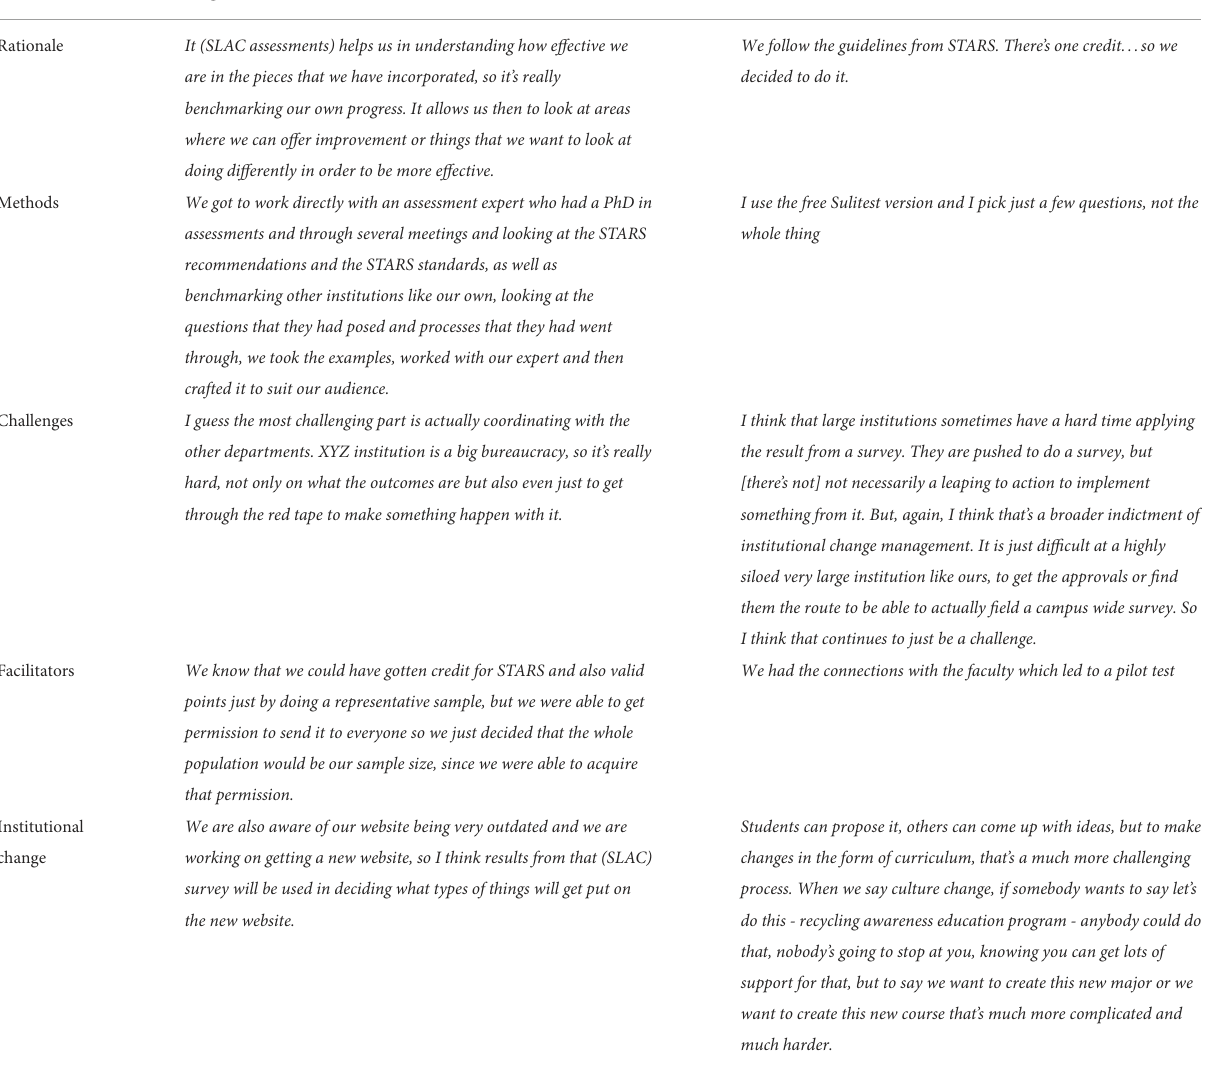
TABLE 3 Characteristic quotes from U.S. R1 institutions on conducting SLAC assessments. High OL Low